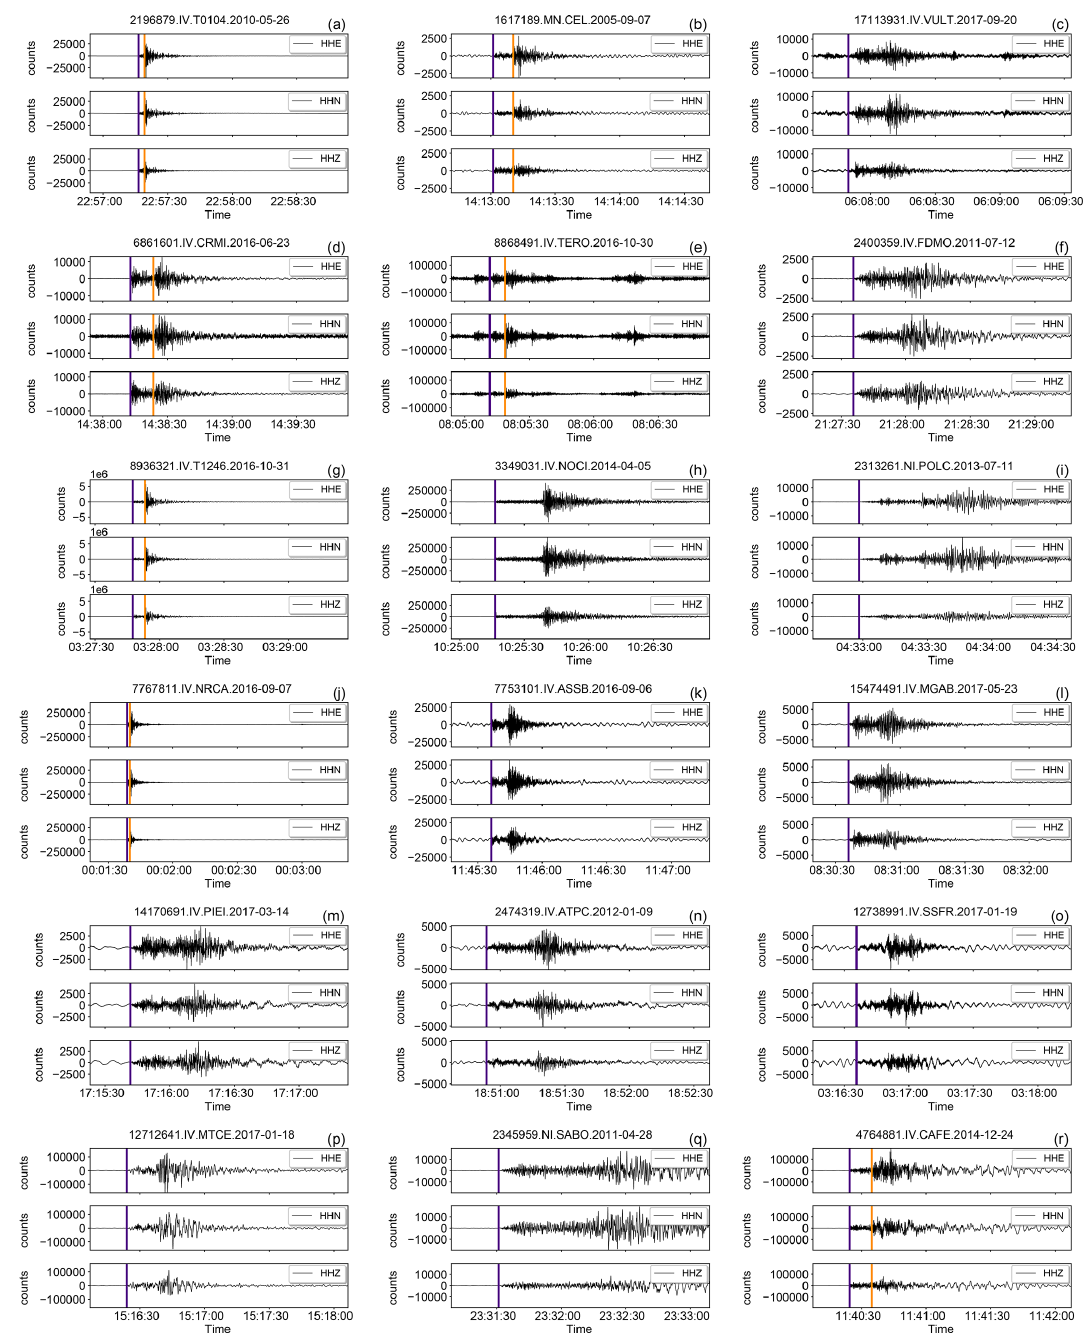
Figure 14. Example of earthquake waveforms of the broadband HH channels contained in INSTANCE randomly drawn according to different criteria based on the metadata provided in Table 2. Each row contains three, randomly selected, 3C traces based on the follow- ing criteria: (a–c) earthquakes 2 ≤ M < 3 (66.8% of the total of the HH channels); (d–f) earthquakes 3 ≤ M < 4 (13.5%); (g–i) earth- quakes M ≥ 4 (2.0%); (j–l) earthquakes trace_E_snr_db ≥ 10 and path_ep_distance < 100km (55.0%); (m–o) earthquakes trace_E_snr_db ≥ 10 and path_ep_distance ≥ 100km (10.8%); (p–r) earthquakes M ≥ 4 and trace_E_snr_db ≥ 10 (1.7%). The arrival times of P- and S-wave onsets (i.e., trace_[P,S]_arrival_time ) are shown by indigo and dark orange vertical lines, re-